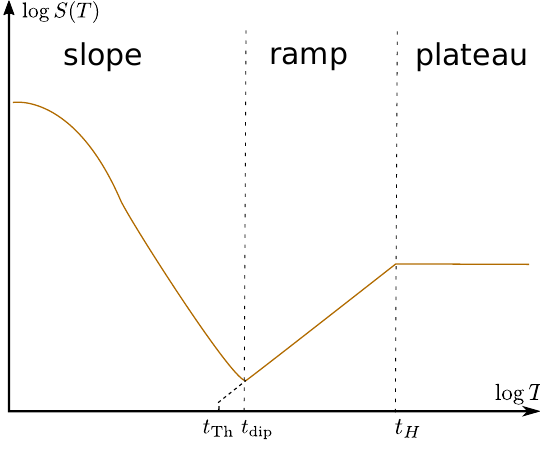
Figure 1 . A sketch of the spectral form factor time